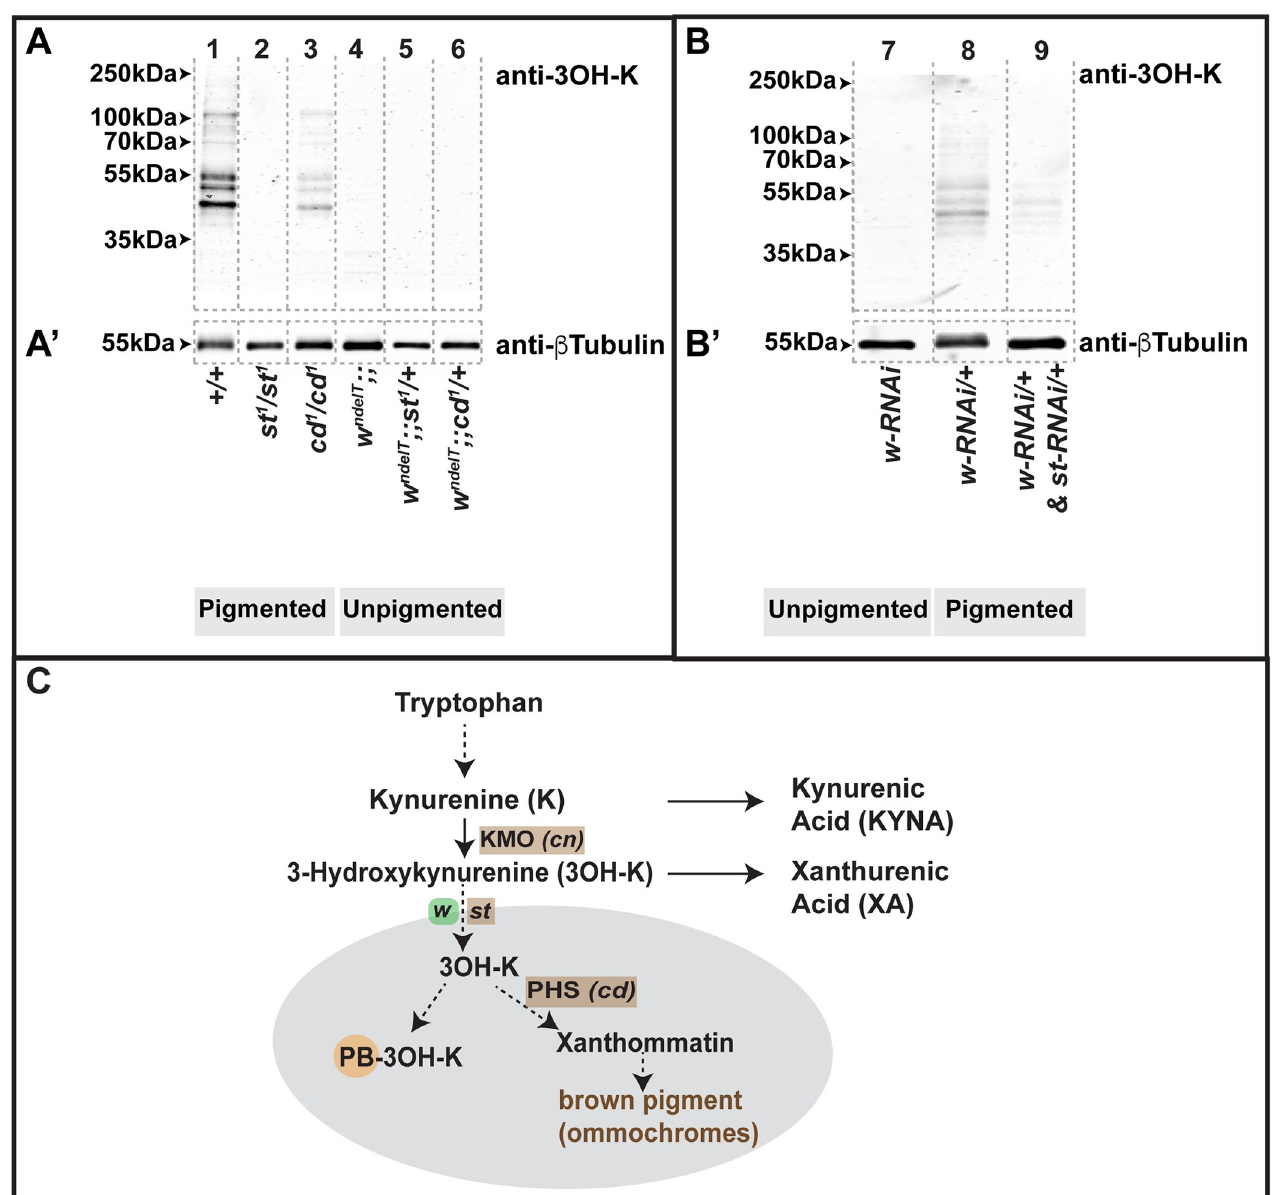
Fig 5. Perturbation of the Kynurenine pathway affects the amount of protein-bound 3OH-K. A-B’: Western blots of protein extracts from heads of flies of different genotypes raised on normal food under physiological/non-degenerative conditions. Blots were tested with antibodies against 3OH-K (A, B) and ß- Tubulin as loading control, run on parallel gels (A’, B’). Numbers on the top of the lanes correspond to the genotypes listed below. Positions of standard molecular weight markers are indicated by arrowheads. Vertical, grey dotted lines outline the lanes. C: A cartoon depicting selected steps of the Kynurenine pathway. Kynurenine 3-monooxygenase (KMO) and Phenoxazinone synthetase (PHS) are enzymes encoded by cinnabar ( cn ) and cardinal ( cd ), respectively. White and Scarlet, encoded by white ( w ) and scarlet ( st ), respectively, compartmentalize free 3OH-K through their transporter activity into LROs (grey). The schematic represents the emerging hypothesis from the experiments shown in A-B’ that 3OH-K can be bound to proteins (PB-3OH-K) only following its transport into LROs by White and Scarlet. to proteins only upon its transport into LROs (Fig 5C) by functional White/Scarlet [41]. PB- 3OH-K was also decreased upon the concomitant knockdown of st and w by RNAi (Fig 5B lane 9) as opposed to knockdown of w alone (Fig 5B, lane 8).